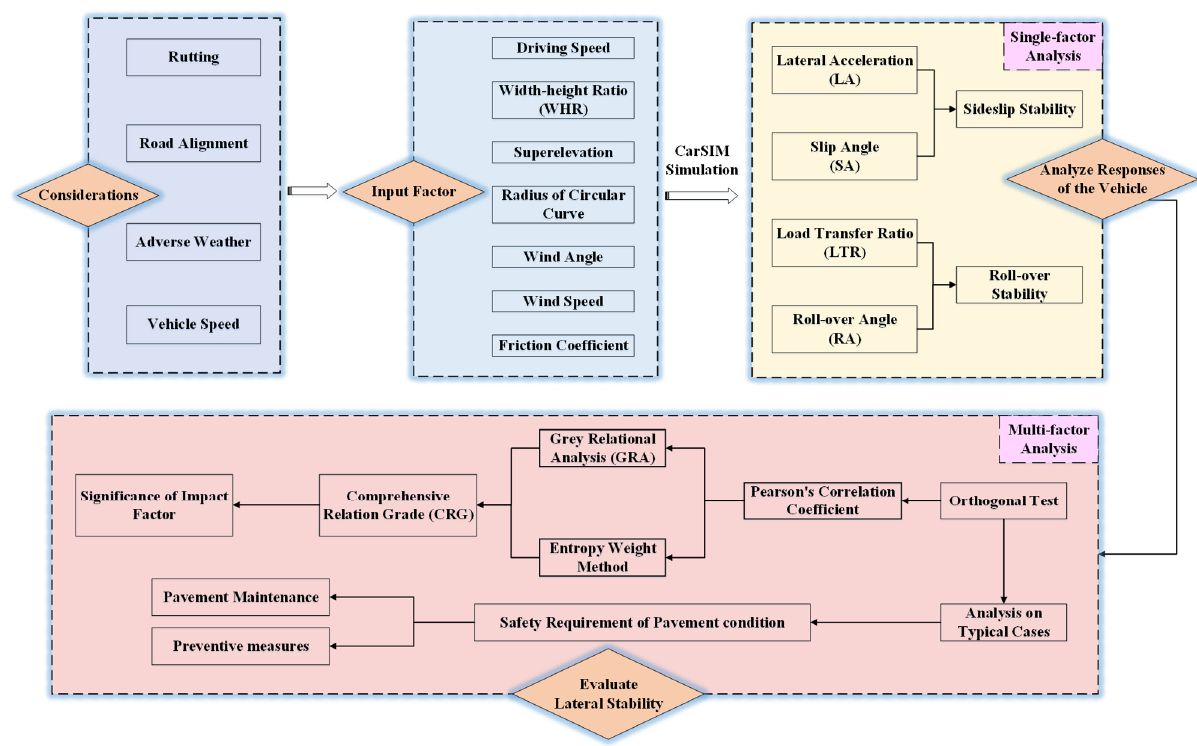
Figure 1. Technical framework of this study.